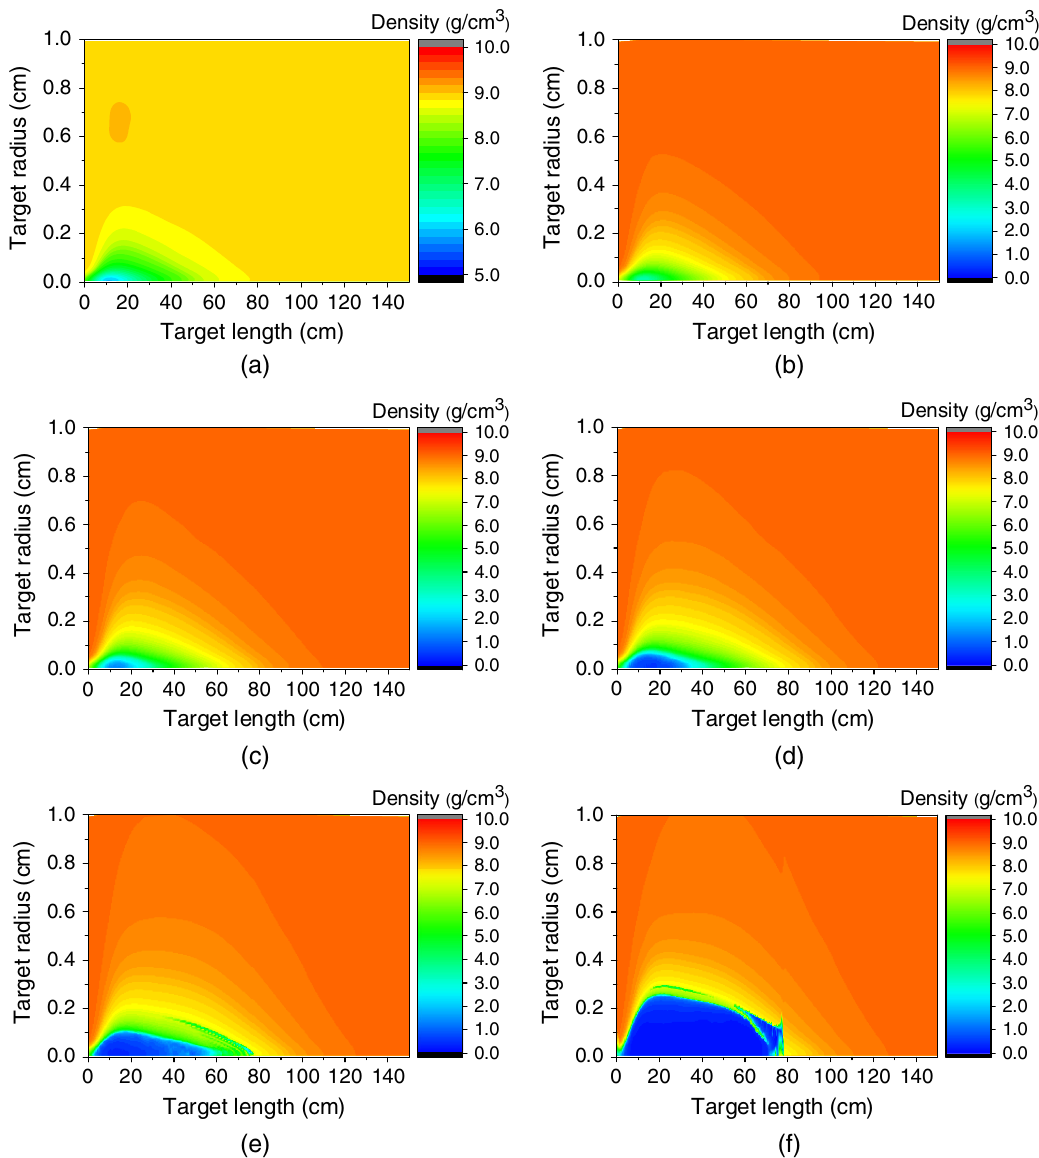
FIG. 10. Two-dimensional distributions of density in the r - z plane calculated by Autodyn (a) at t ¼ 1 . 8 μ s, after 36 bunches have been delivered, (b) at t ¼ 3 . 8 μ s, after 72 bunches, (c) at t ¼ 5 . 8 μ s, after 108 bunches, (d) at t ¼ 7 . 8 μ s, after 144 bunches, (e) at t ¼ 10 μ s, 2 . 2 μ s after the delivery of the beam, and (f) at t ¼ 20 μ s, 12 . 2 μ s after the delivery of the beam. Note that a different color scale is used in (a) to show the compressed